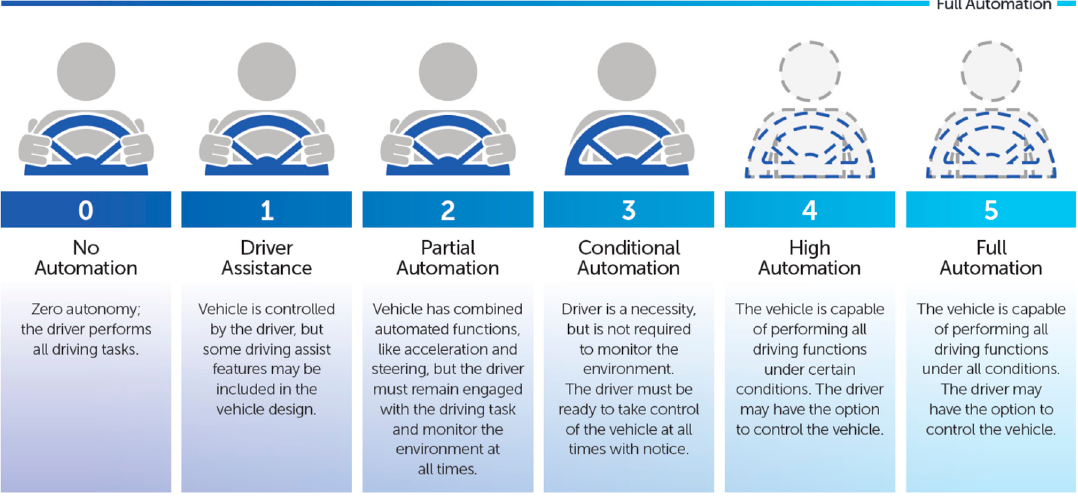
Figure 2. Society of Automotive Engineers (SAE) automation levels [2] .